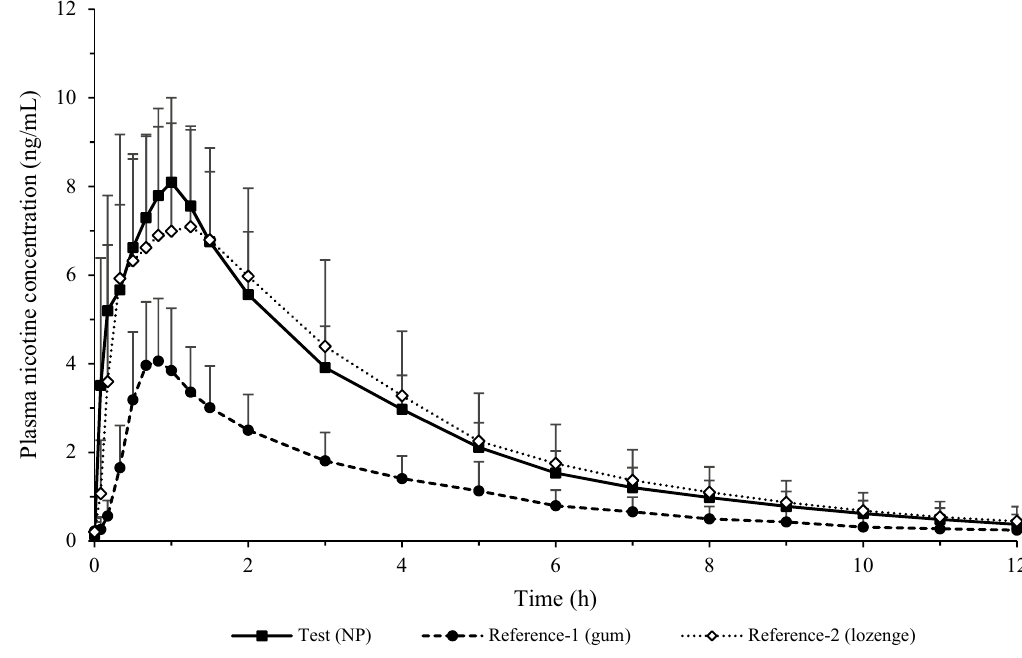
Figure 2. Baseline-unadjusted mean plasma nicotine concentrations among adult smokers (N = 32) after single oral product use of three nicotine products under fasting conditions.